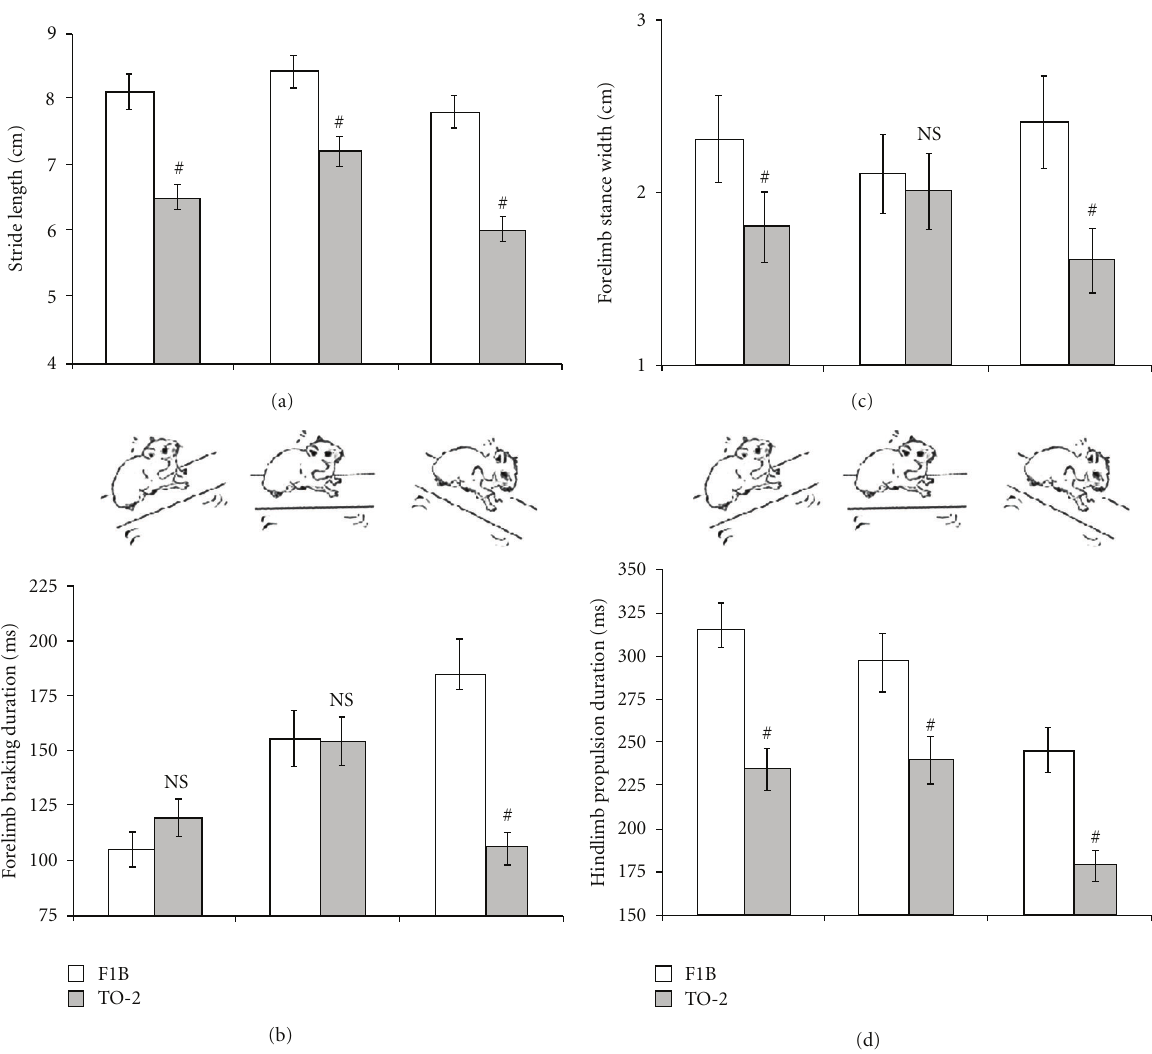
Figure 4: Three-month old TO-2 dystrophic hamsters exhibited significant gait di ff erences that were consistent with those observed in 9- month-old animals. (a) Stride length was shorter and (b) stance width narrower in 3-month-old TO-2 hamsters. (c) Di ff erences in forelimb braking duration and (d) hindlimb propulsion duration while walking horizontally [center bars] were exacerbated with uphill walking [left bars] and downhill walking [right bars]. # P < . 001 TO-2 compared to